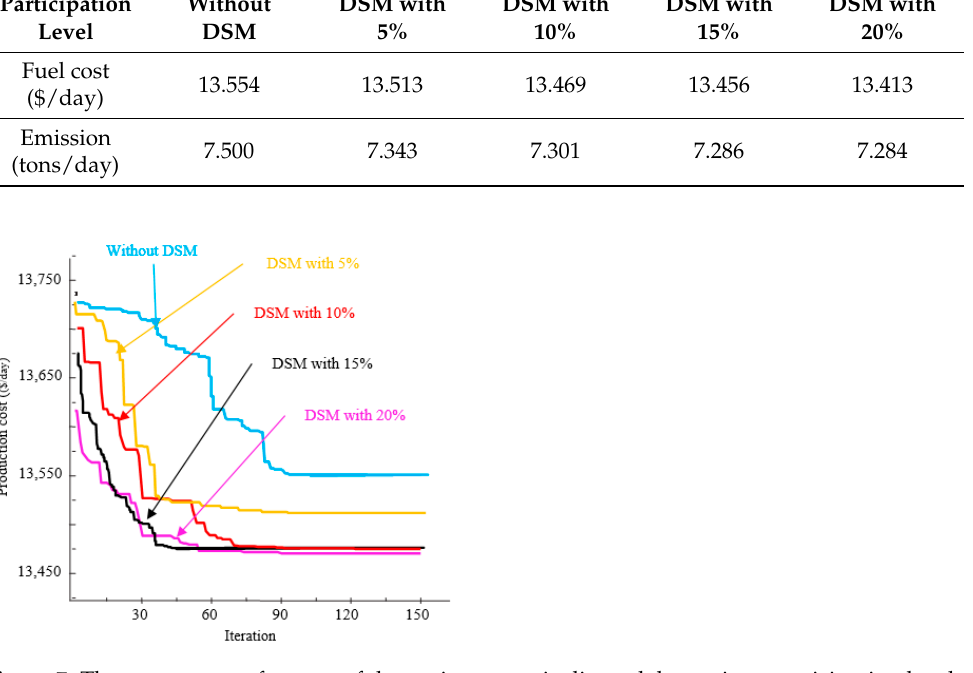
Figure 7. The convergence features of dynamic economic dispatch by various participation levels of DSM.